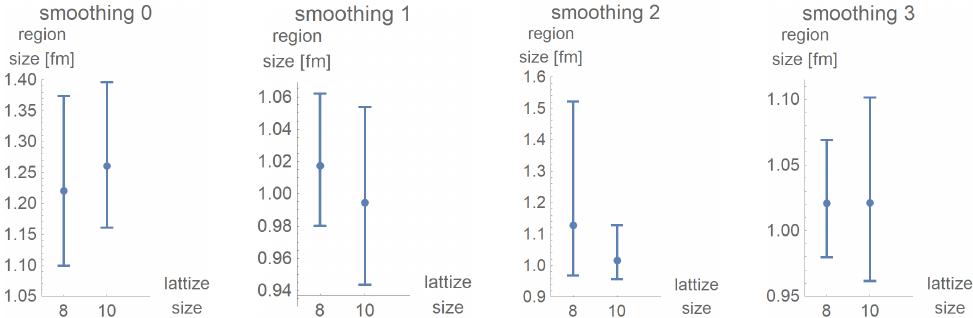
Figure 17. Estimated size of color-homogeneous regions after five cooling